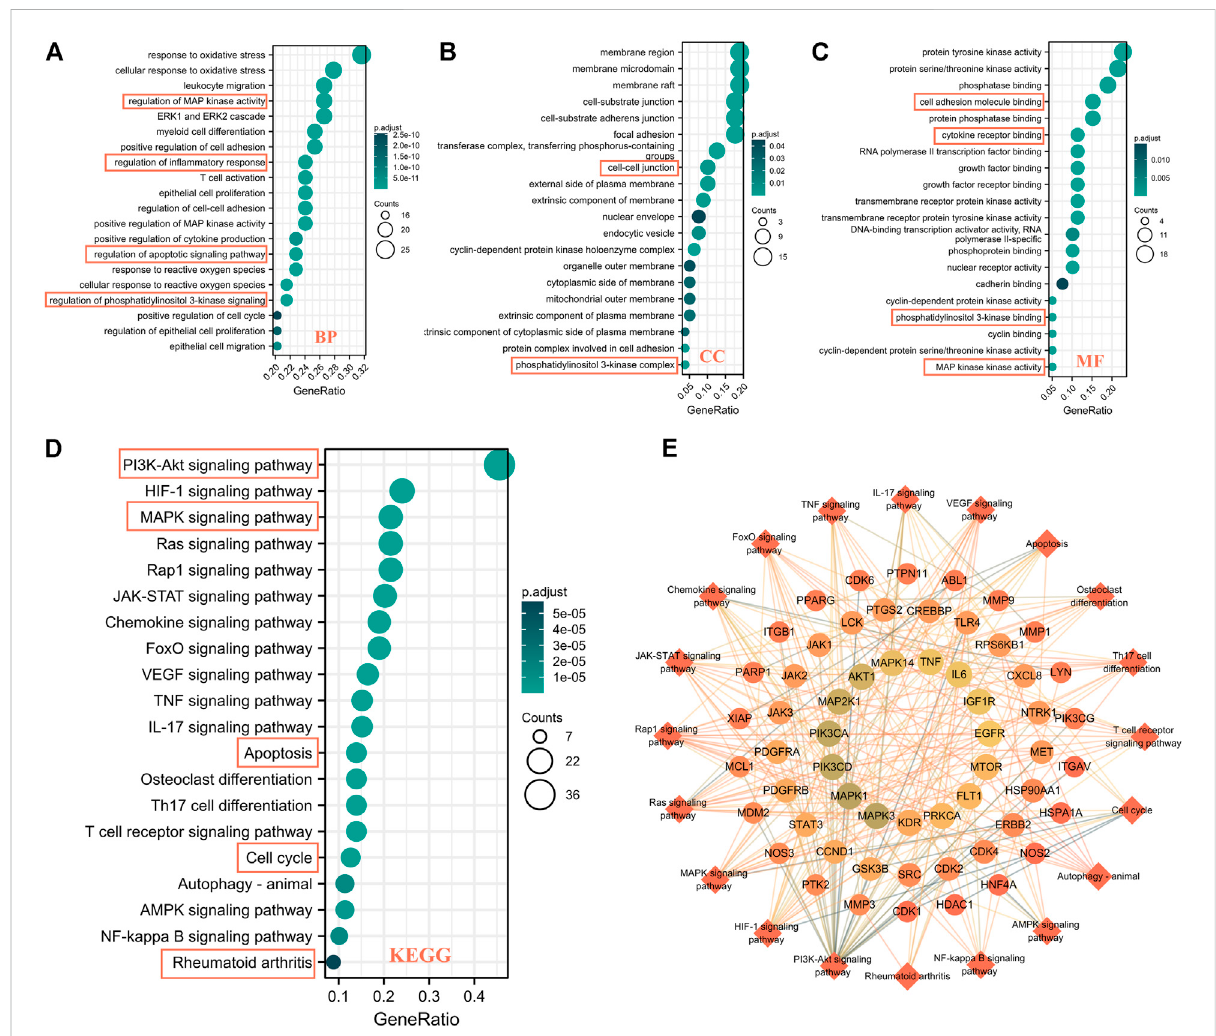
FIGURE 3 GO and KEGG pathway enrichment analysis of 79 potential key targets of WPW for RA treatment. (A) BP. (B) CC. (C) MF. (D) KEGG enrichment pathway. (E) A network diagram of target-signaling pathways.